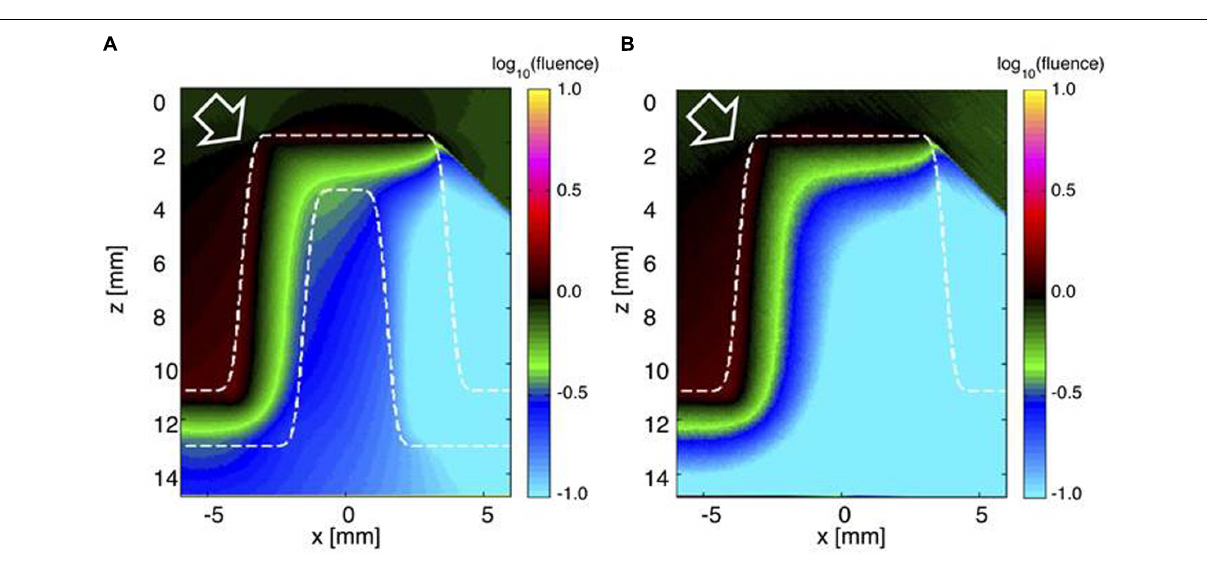
FIGURE 5 | Monte Carlo simulation of light distribution in a faviid coral under oblique incident illumination. The white arrow indicates the direction of incident collimated light (at 45 ◦ ). (A) The 2D distribution of relative 636 nm fluence rate φ ( z , x ) across the model coral (tissue and skeleton). (B) The φ ( z , x ) image if the skeleton was replaced by living